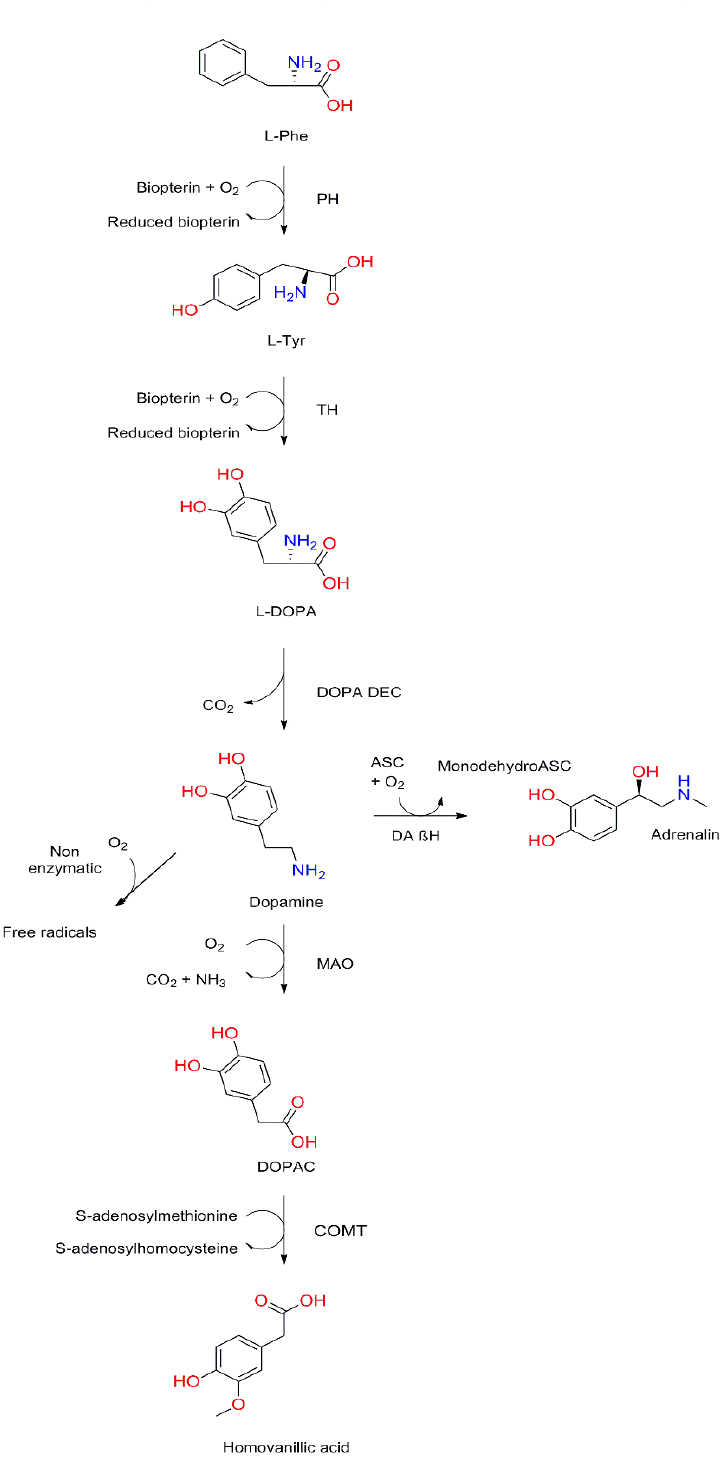
Figure 1. Dopamine synthesis and degradation pathways. L-Phe, L-phenylalanine; PH, phenylalanine hydroxylase; L-Tyr, L-tyrosine; TH, tyrosine hydroxylase; L-DOPA, levo-dopa; DOPA DEC, L-DOPA decarboxylase; ASC, ascorbic acid; DA β H, dopamine β -hydroxylase; MAO, monoamine oxidase; DOPAC, 3,4-dihydroxyphenylacetic acid; COMT, catechol-o-methyltransferase.